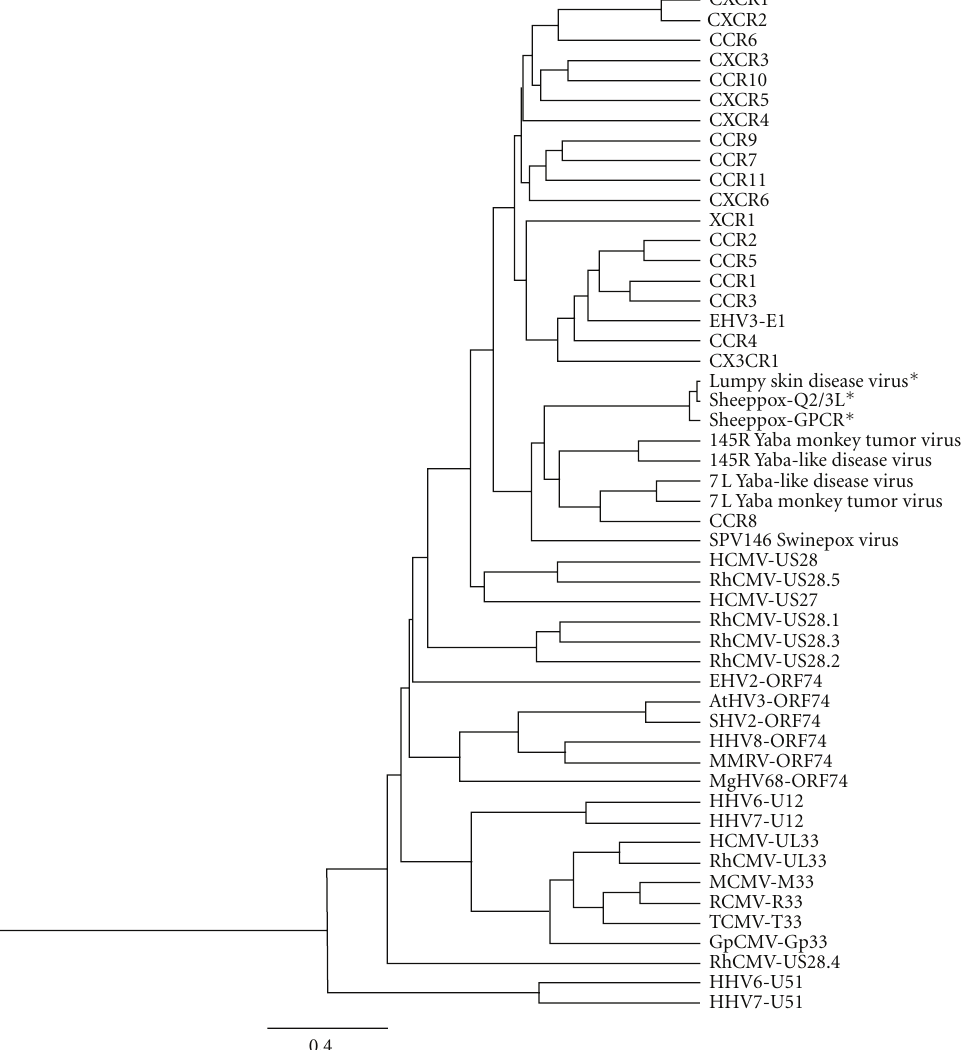
Figure 1: Phylogenetic tree of viral and human chemokine receptors based on their amino acid sequence. The length of each branch reflects the similarity between receptors. It was generated by aligning the sequences using the settings: Blosum62, gap open penalty of 5 and gap extension penalty of 0.1 followed by the Jukes-Cantor distance analysis done in Geneious Pro. For further information about the virus- encoded receptors and GenBank accession number please see Table 1. ∗ As the sequence of these viral receptors are very alike it cannot be excluded that they are in fact the